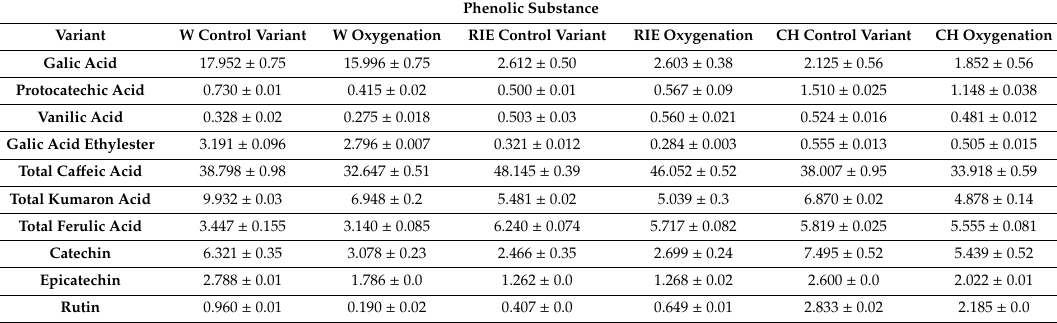
Table 4. Content of 10 monitored phenolic substances in mg · L − 1 from individual variants in 2015 with the standard